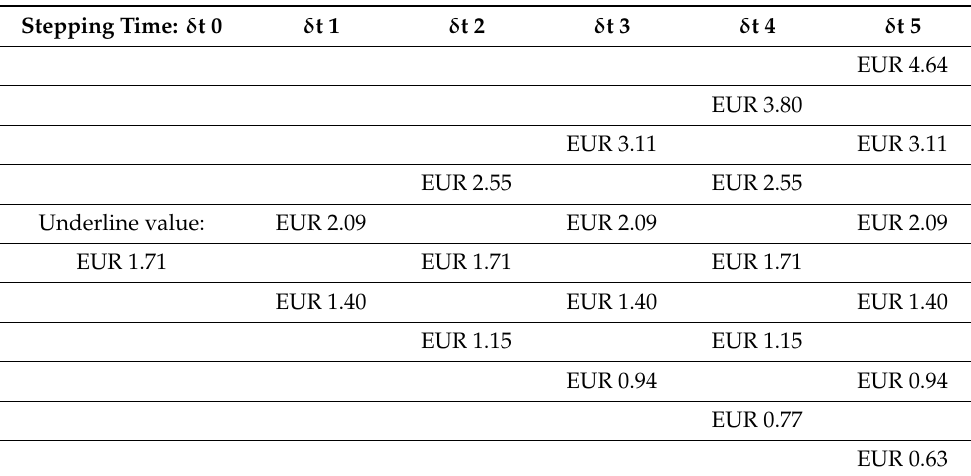
Table 6. Binominal option-pricing model: a lattice of the underline values of Nordea and DNB Baltic branches merger (in €